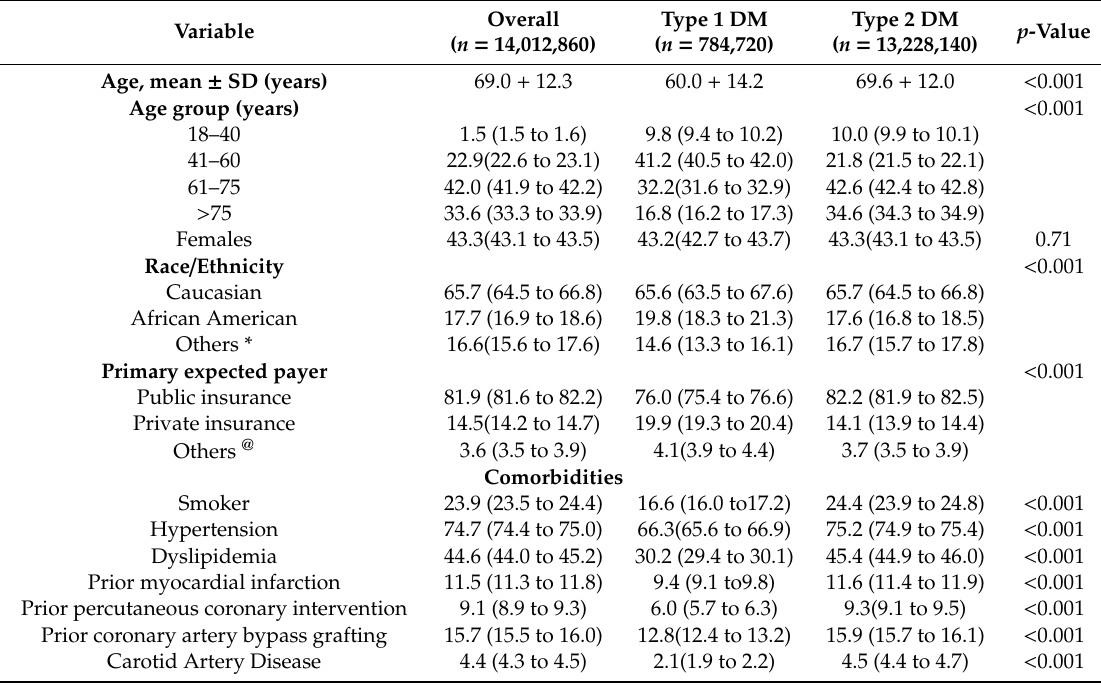
Table 1. Demographics and comorbidities in PAD-related procedural hospitalizations for patients with type 1 and type 2 diabetes